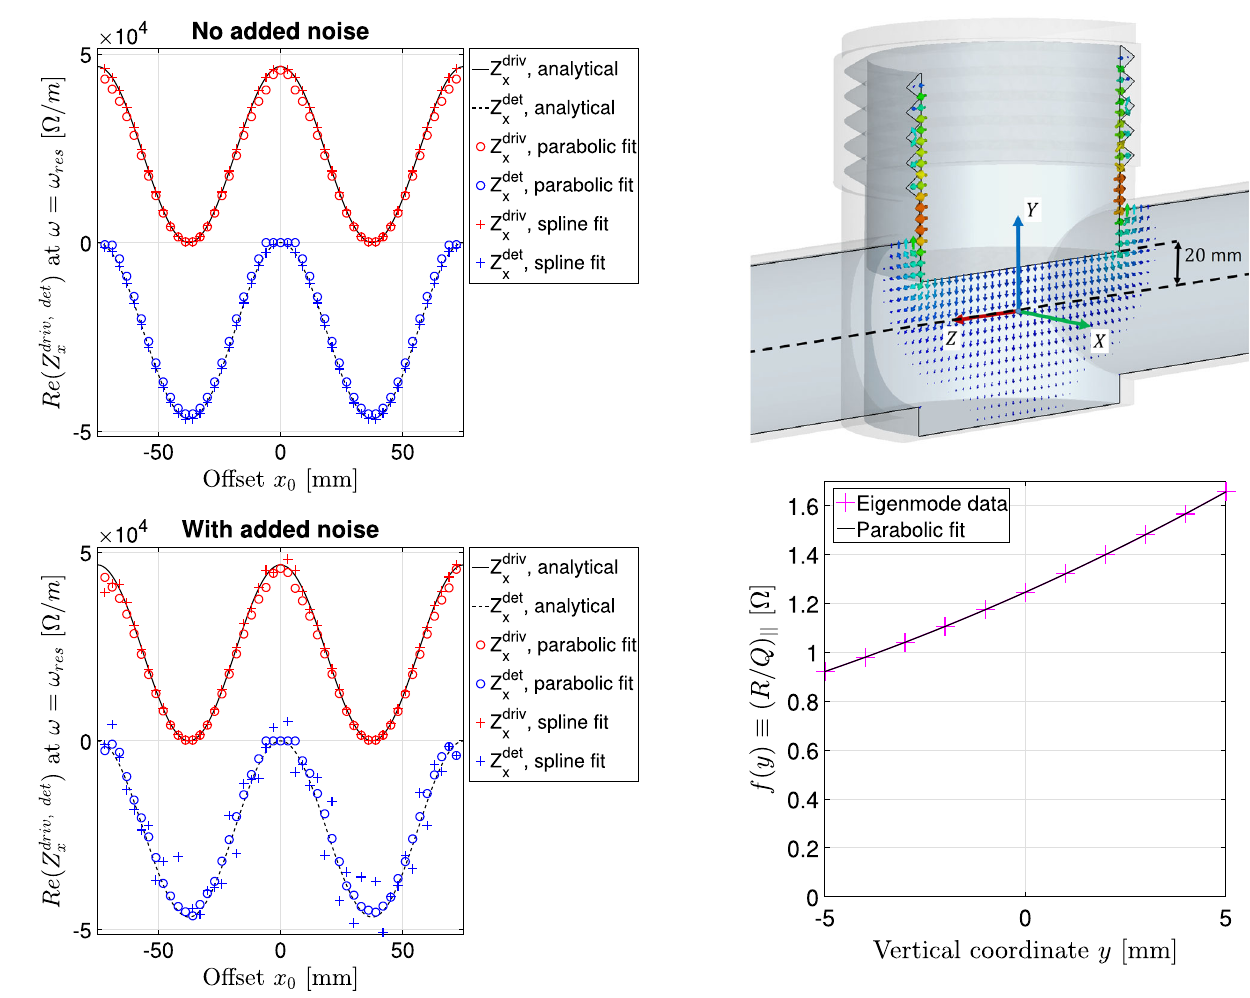
FIG. 4. Driving and detuning impedances obtained by the eigenmode method, compared to the analytical expressions. Top: the original eigenmode data is taken without added noise. Bottom: random errors of the amplitude of 0 . 025 Ω were added to the eigenmode data.